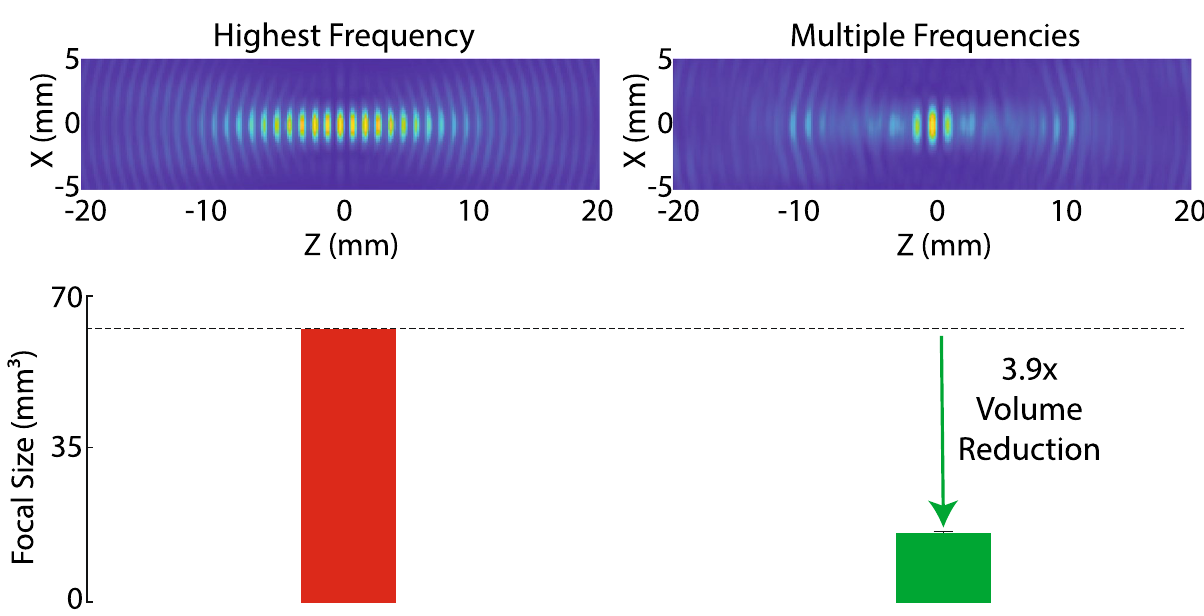
Figure 2. MFS performance. Simulated ( a ) and measured ( b ) fields provided by the traditional single- frequency emission from a single aperture (left column), single-frequency emission from opposing apertures (middle column), and MFS (right column). The corresponding focal volumes are quantified using the bars on the bottom (mean ± s.d.).